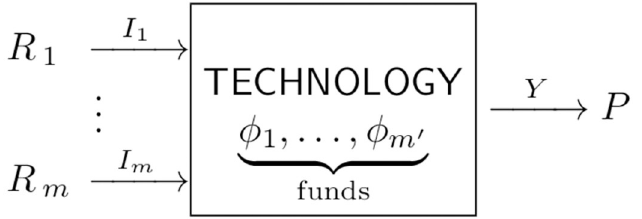
Fig 1. Representing technology as a converter of material resources into product. The set of resources R 1 , ... , R m , which can be raw materials, semiproducts, parts, or other commodities, are jointly transformed into a product P under the “catalytic” action of the set of funds ϕ 1 , ... , ϕ m 0 . The arrow labels stand for respective flows.